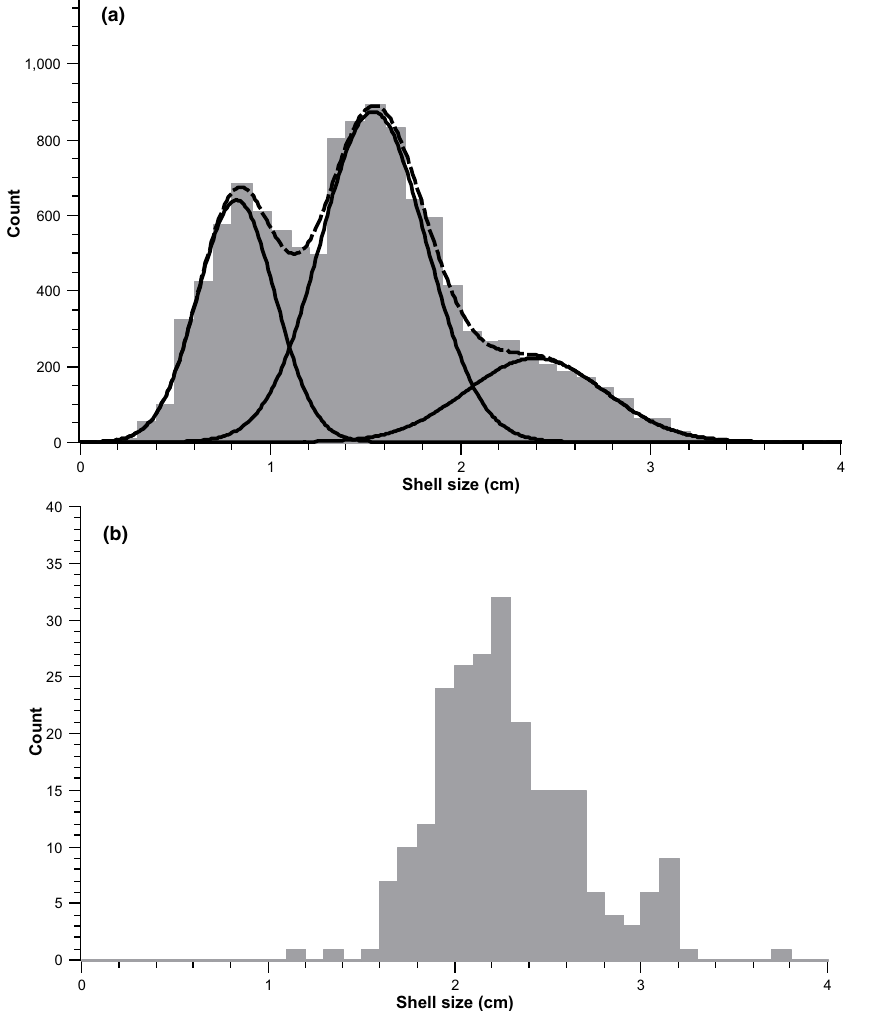
Fig. 2. (a) Distribution of shell lengths for L. littorea sampled from Strangford Lough ( n =11,408). Normal distributions for three separate age classes were fi tted using a mixture model. The dashed line shows predicted counts from the combined normal distributions. (b) Shell lengths of L. littorea bought at the fi sh market in Belfast ( n